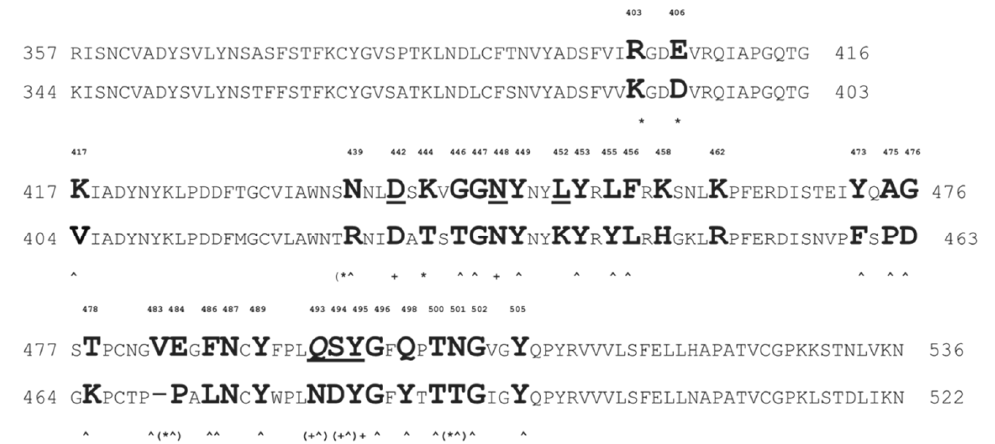
Figure 12. Primary protein structures of the RBD domain of SARS-CoV-2 (upper line) and SARS-CoV (bottom line) aligned using BLASTP. Amino acid residues involved in the interaction (designated by capital bold letters) between FGFR3 (marked with a *) and ACE2 (marked with a ˆ) were identified using the YASARA Structure and literature data [97]. Promiscuous AA of the SARS-CoV-2 RBD involved in binding both FGFR3 and ACE2 are marked with *ˆ. Members of AA cluster D442, N448, Y449, S494, Q493, L492, corresponding to phage mimotope EDYSELVSQ, are underlined and marked with (+).